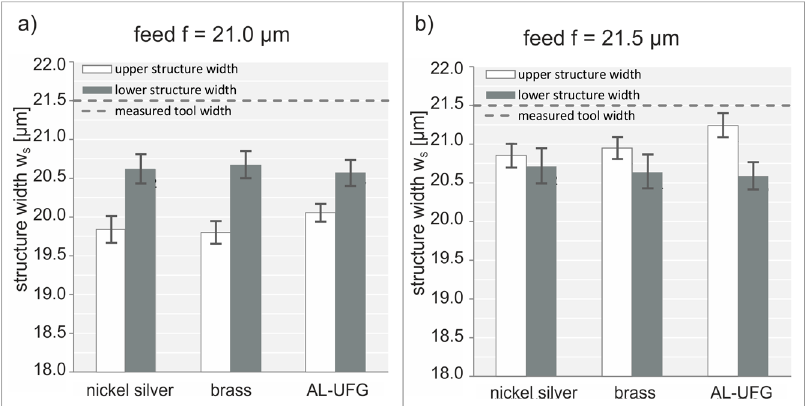
Figure 4. Influence of the material on the structure width ( a ) with a feed of f = 21.0 μ m and ( b ) with a feed of f = 21.5 μ m.